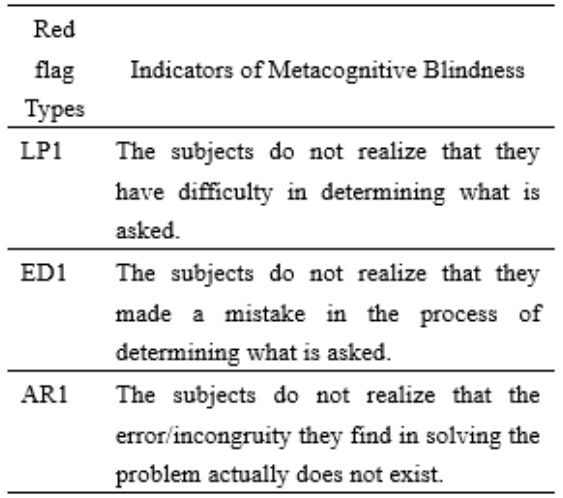
Figure 1. Mathematical Problem-Solv- ing